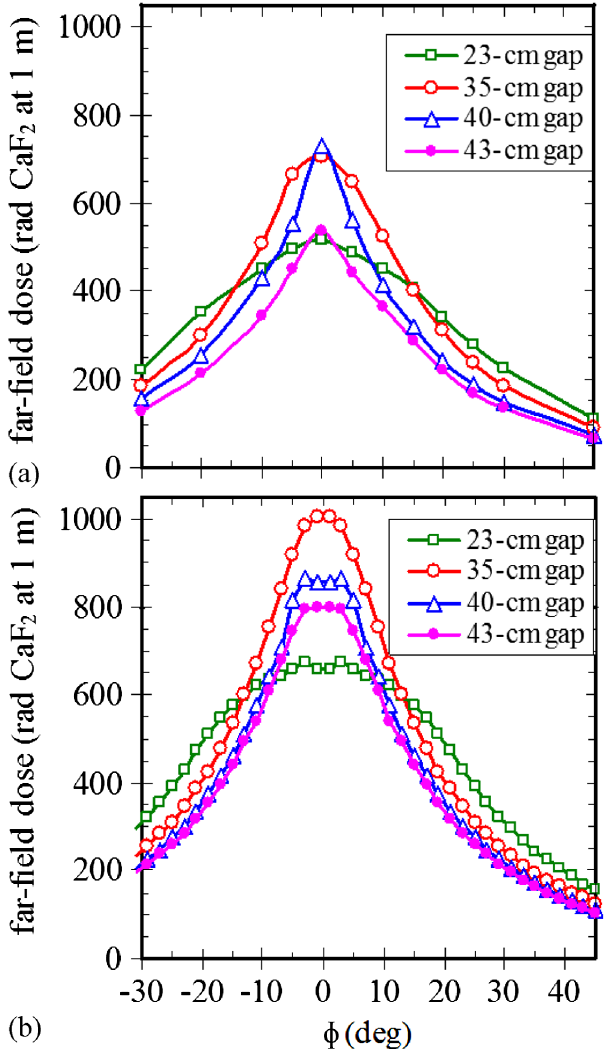
FIG. 10. (a) Measured time-integratedangulardosedistributions fromTLDsforvariousdiodegaps.(b)LSP/ITSpredictionsoftime- integrated angular dose distributions for various diode gaps.